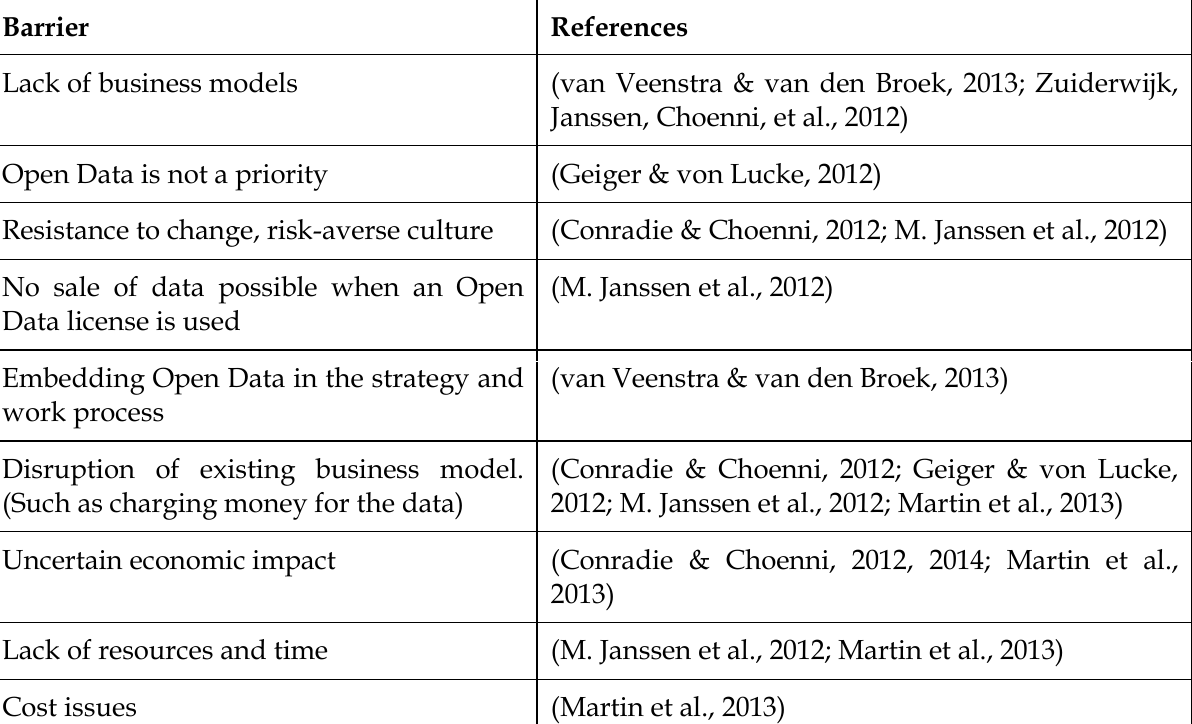
Table 5: Strategic and Business barriers (Source: Authors)